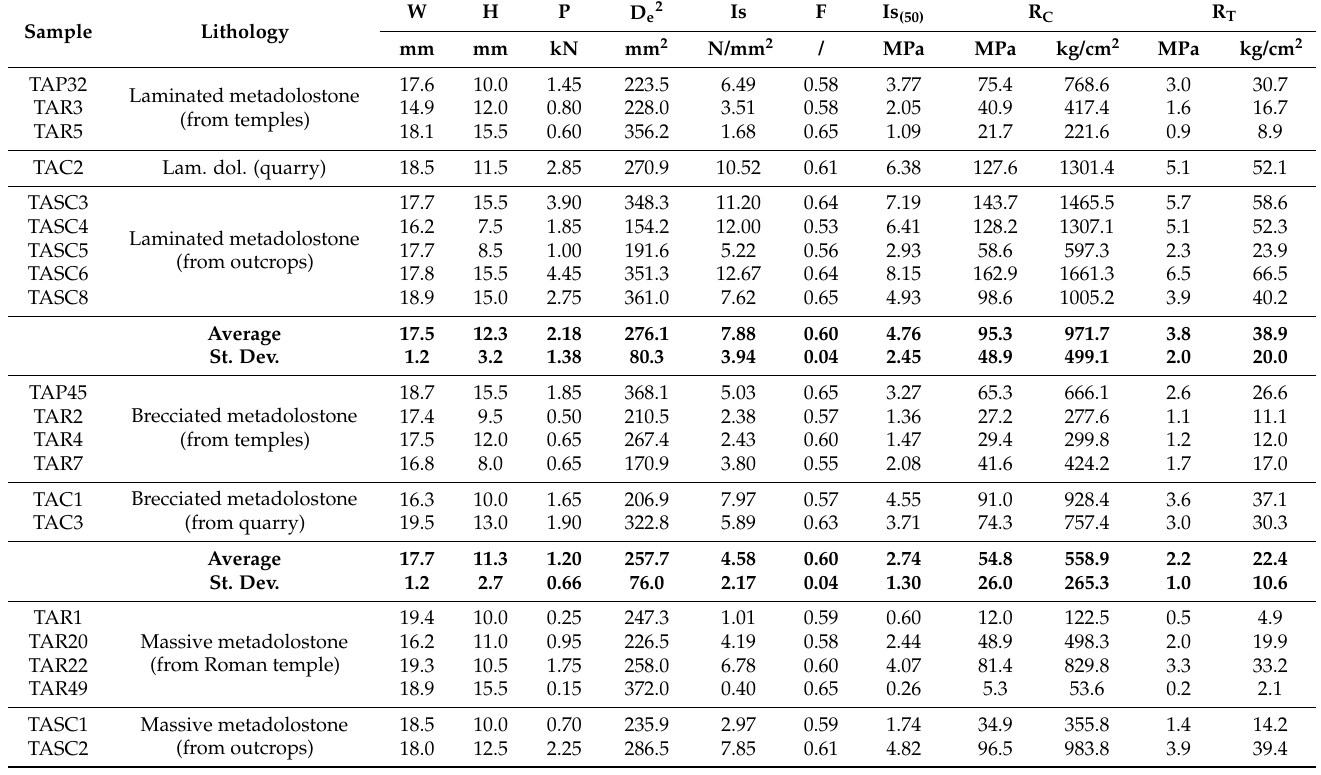
Table 4. Point Load Test data. Symbol legend: W = width of specimen; H = height of specimen; P = breaking load; D e = equivalent diameter; Is = strength index; F = correction factor; Is (50) = Point Load Test index normalised to cylinder specimen with diameter of 50 mm; R C = indirectly calculated compression strength; R T = indirectly calculated tensile strength.